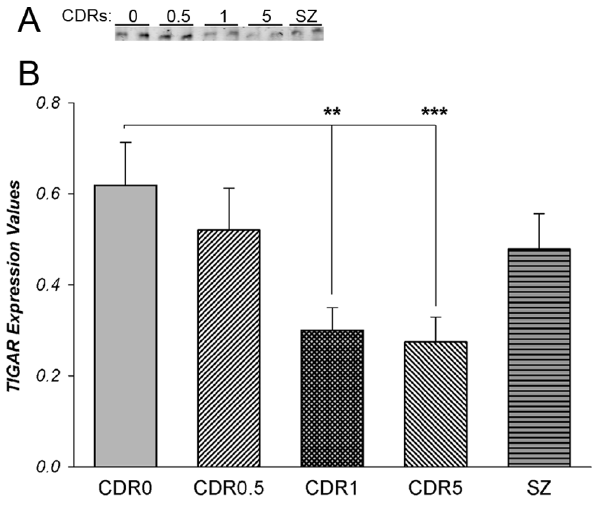
Figure 4. Western blot (A) and protein expression levels of TIGAR (B) in STG (BA22) in dementia (CDRs . 0.5) and schizophrenia. TIGAR expression values were normalized to GAPDH. **-p # 0.01; ***-p # 0.001.